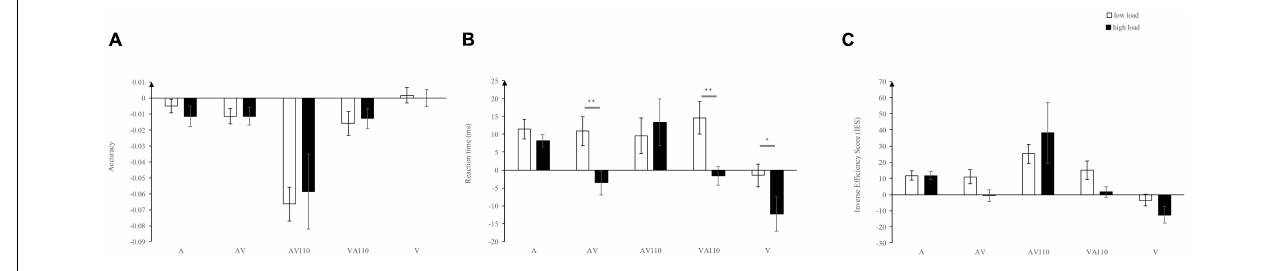
FIGURE 4 | Validity effects in terms of accuracy (A) , reaction times (B) , and inverse efficiency score (C) , using data from the two experiments. Error bars denote ± SE. ** p < 001, and * p <